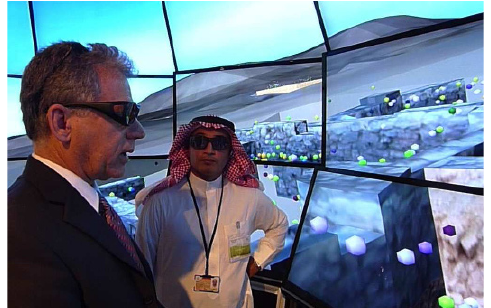
Figure 11. Tom Levy and Sami Maghlooth in the KAUST NexCAVE reviewing the VR reconstruction of UCSD’s excavation at Khirbat en-Nahas in southern Jordan. Content: Kyle Knabb and Jurgen Schulze. Photo: Tom DeFanti.